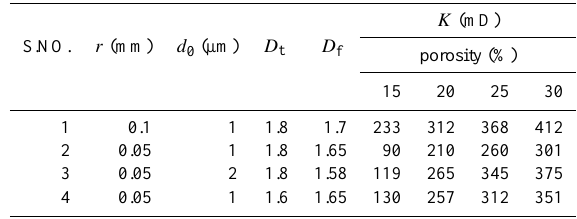
Table 2. Estimated permeability ( K ) for a range of porosities and for different values of grain radius ( r ), minimum particle size ( d 0 ) , tortuosity fractal dimension ( D t ) and pore area fractal dimension ( D f ) .